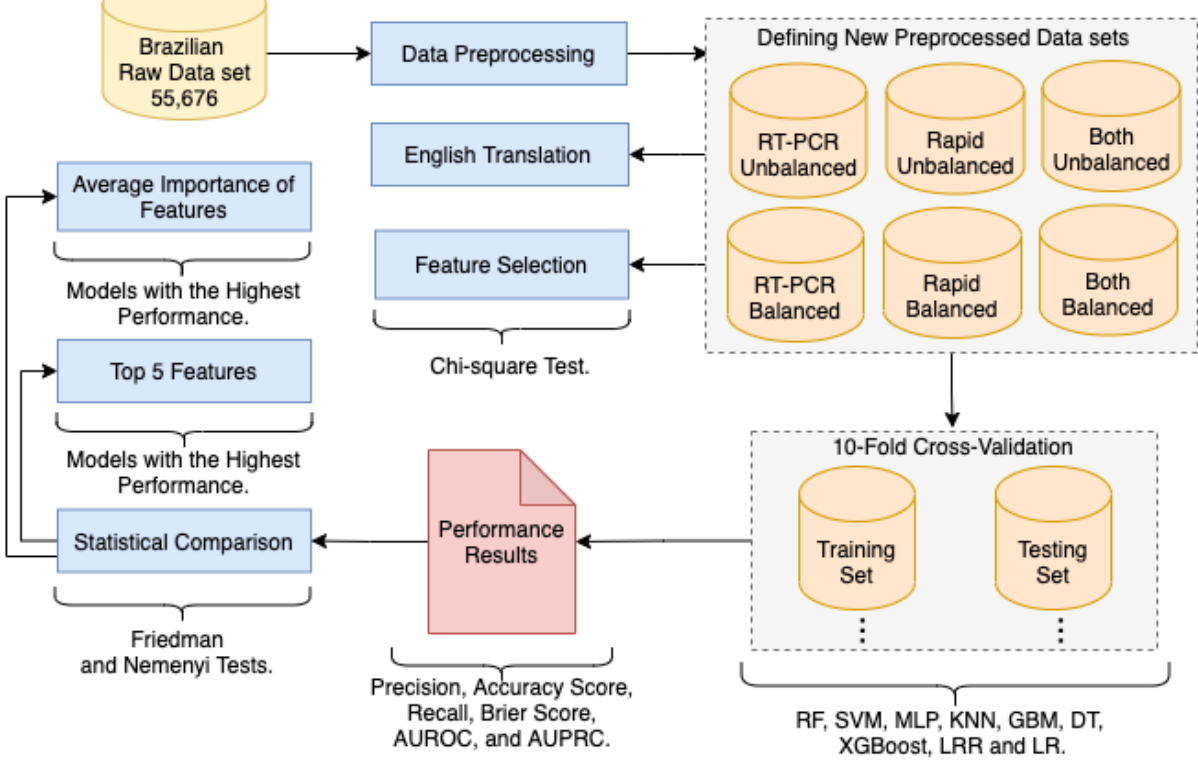
Figure 1. Overview of the research methodology applied for the study. The methodological steps consist of data preprocessing, the definition of new data sets, English translation, feature selection, 10-fold cross-validation, statistical comparisons, and feature ranking. AUPR: area under the precision-recall curve; AUROC: area under the receiver operating characteristic curve; DT: decision tree; GBM: gradient boosting machine; KNN: k-nearest neighbors; LR: logistic regression (weak regularization); LRR: logistic regression (strong regularization); MLP: multilayer perceptron; RF: random forest;